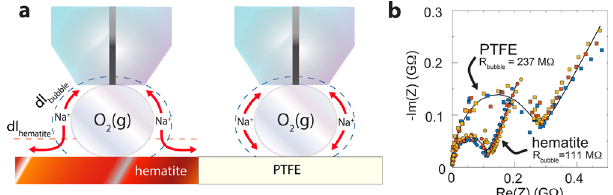
Fig. 3 EIS response of bubbles pinned on semi-conducting and insulating surfaces. a Schematic representation of sequential EIS measurements of a single oxygen bubble, fi rst on semi-conducting hematite then after displacement on an adjacent insulating PTFE support. b Nyquist (complex- plane impedance) plot showing real (Re) and imaginary (Im) impedance (Z) data (triplicates denoted by colored circles and squares) and model (lines) of an oxygen bubble pinned on hematite (circles) and PTFE (squares) in an aqueous solution of 1.0mM NaCl at 25°C. Measurements were collected over an applied alternating current of ±50mV in the 1 – 10 5 Hz range. Solid lines are fi ts from the equivalent circuit model of Fig. 2d, and result from contrasting bubble resistance values ( R bubble ). More results are in Supplementary Fig. 6. concept that both PTFE and the air/water interface are populated by hydroxide ions and counteractions, and have similar isoelectric points 20,21 . The hike in resistance reveals, on the other hand, that ion transport between the two compositionally similar bubble and PTFE surfaces is inhibited. This situation contrasts starkly with the case of bubbles pinned on hematite and gold where more important differences in double layer capacitance and ionic composition facilitate the gateway for ion transport, as manifested by considerably lower resistances than on PTFE.